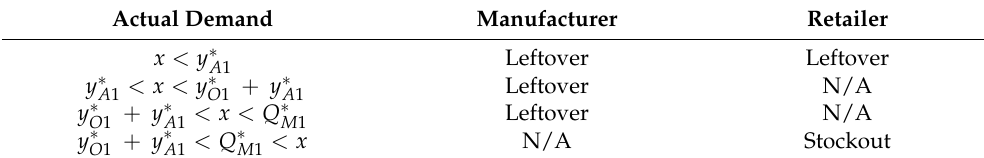
) . , y ∗ , Q ∗ M 1 A 1 O 1 Leftover